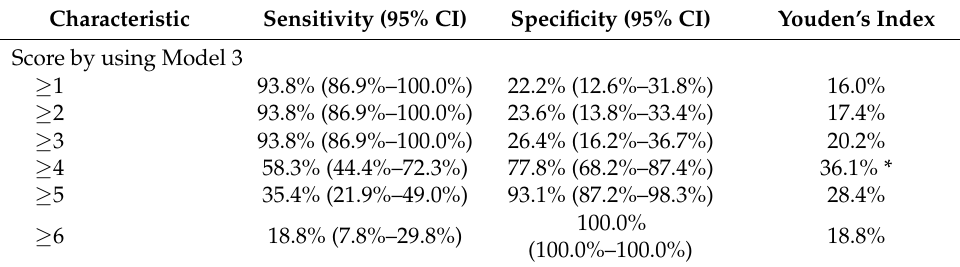
Table 4. Diagnostics of new scoring system (Model 3) for predicting length of stay >14